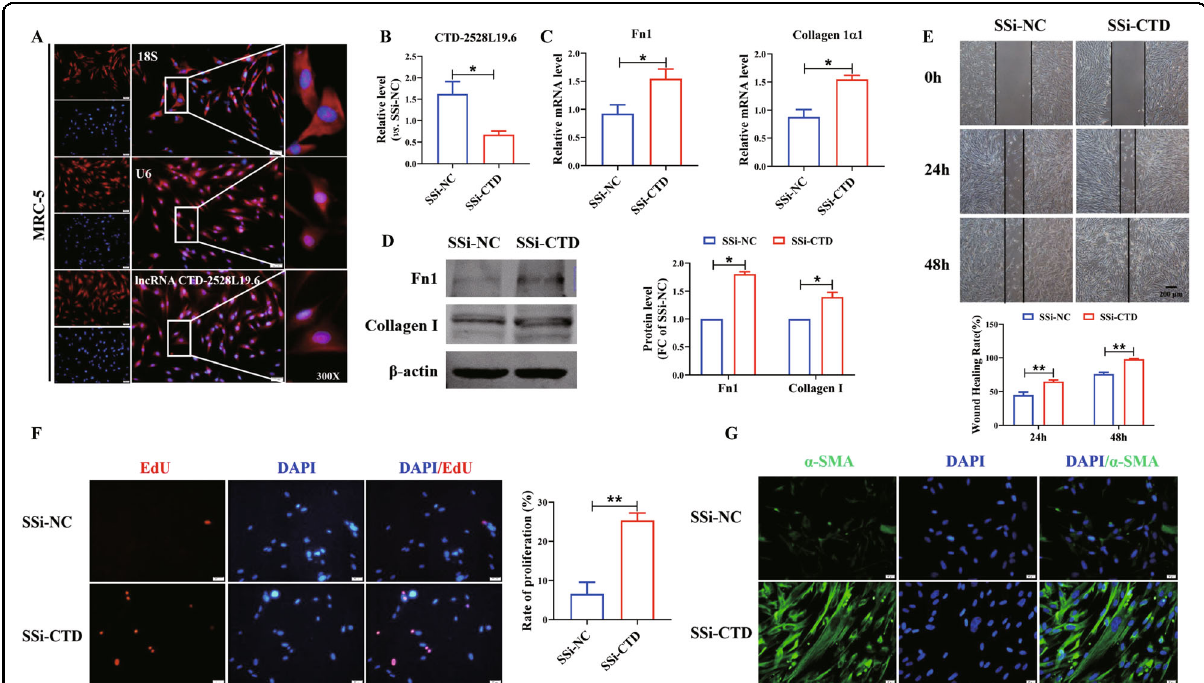
Fig. 6 Silencing CTD - 2528L19 .6 promotes fi broblast activation of MRC-5 cells. A Fluorescence in situ hybridization detects the localization of CTD - 2528L19 .6 in MRC-5 cells. For clarity, CTD - 2528L19 .6 was abbreviated as CTD in the fi gures. 18 S and U6 are the markers of cytoplasm and nuclei, respectively. Blue nuclei are stained with DAPI. Scale bar: 50 μ m. B , C The expression of CTD-2528L19.6 , Fn1, Collagen 1 α 1 after silencing CTD- 2528L19.6 in MRC-5 cells were detected by qRT-PCR. n = 4. D Western blot was used to detect the expression of Fn1 and Collagen I after SSi- CTD transfection. n = 6. Wound-healing migration assay ( E ) and EdU proliferation assay ( F ) were used to assay the effect of SSi- CTD on migration and proliferation in MRC-5 cells. n = 4. Scale bars, 200 μ m in E and 50 μ m in F . G Immuno fl uorescence was applied to examine the fi broblasts into myo fi broblasts transition after transfecting SSi- CTD . Scale bar, 20 μ m. * P < 0.05; ** P <